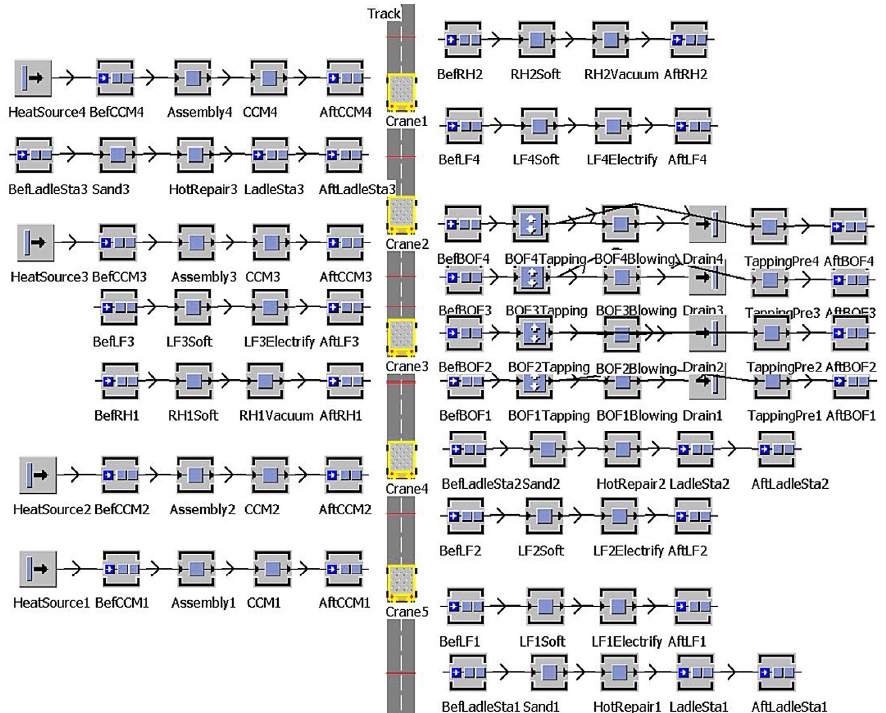
Figure 8. Static model based on the layout of tapping (casting) span in